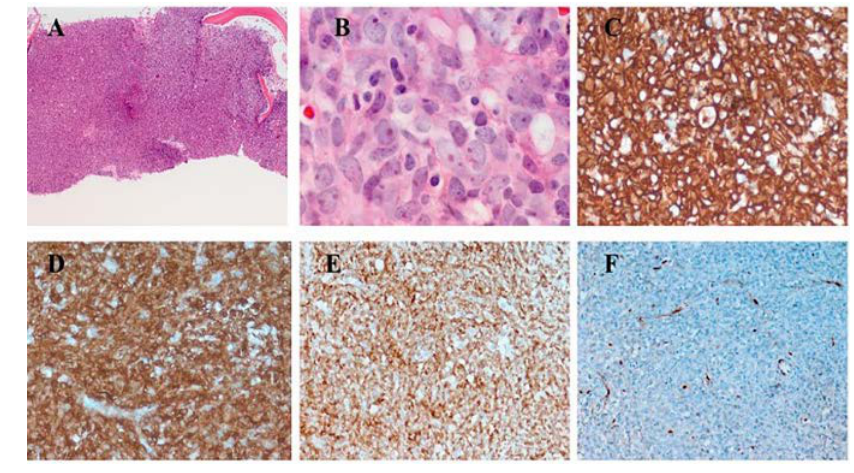
Figure 3. Bone marrow trephine biopsy results. Morphology and immunohistochemistry. A) Hematoxylin-Eosin (40×). B) Hematoxylin-Eosin (1000×). C-D) neoplastic lympho- cytes are positive for CD20 (C, 400×) and CD5 (D, 200×). E) BCL2 expression (200×). F) neoplastic lymphocytes are negative for Cyclin D1